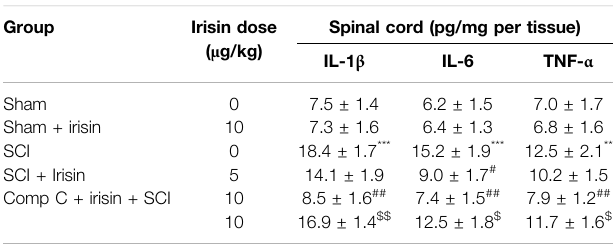
TABLE 2 | Effects of irisin on IL-1 β , IL-6 and TNF- α expressions of spinal cord in rats. Group Irisin dose Spinal cord (pg/mg per ( μ g/kg)